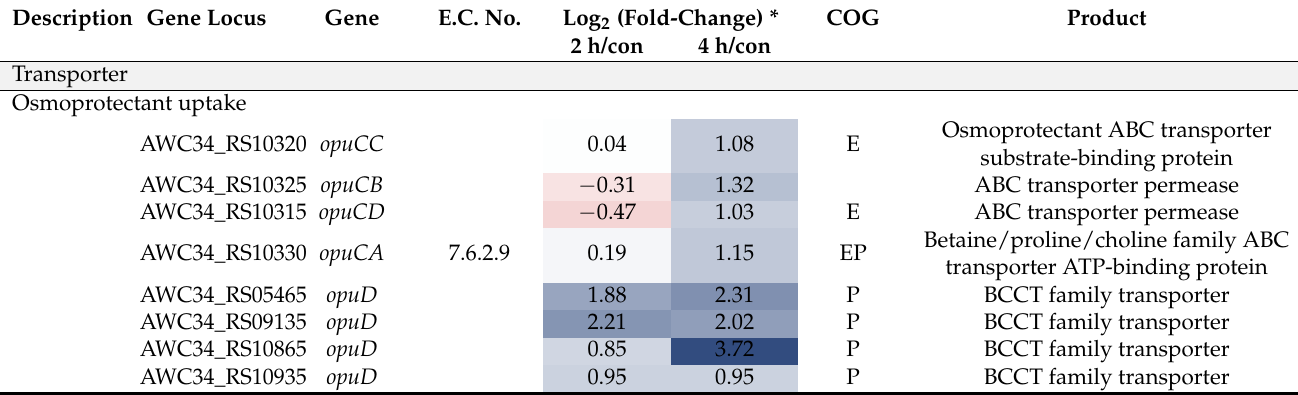
Table 1. Expression of genes predicted to contribute to salt resistance in Staphylococcus equorum KM1031 following treatment with 7%